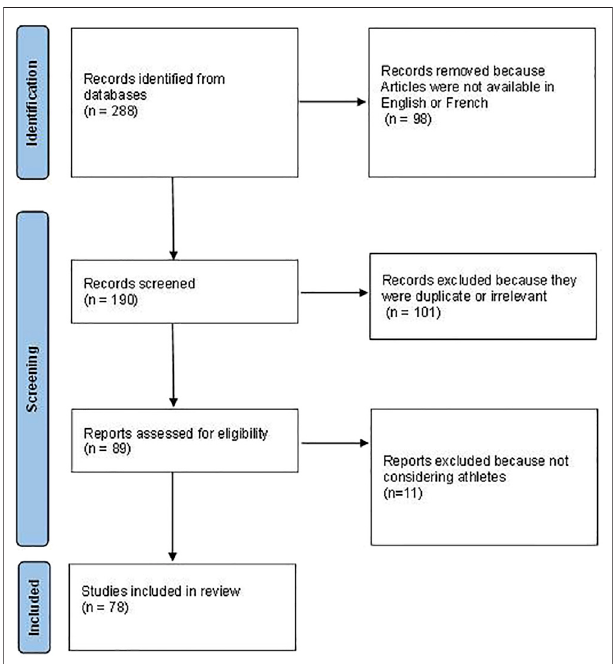
FIGURE 1 | Flow chart of the process of article